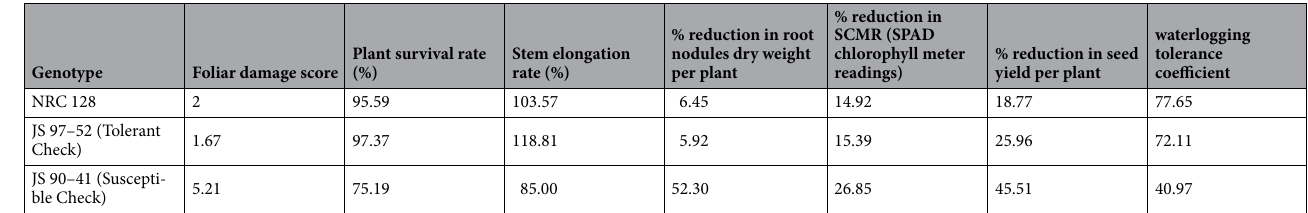
Table 6. Evaluation of NRC 128 for waterlogging tolerance at vegetative stage (V 2 – V 3 ) under controlled conditions.